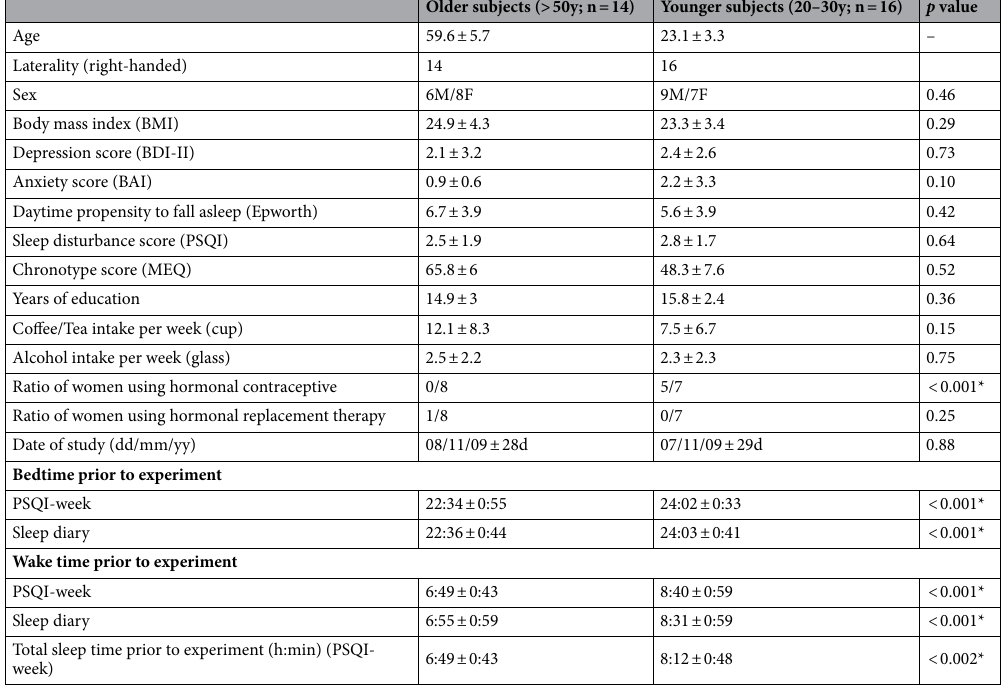
Table 1. Subject characteristics (mean ± SD). BDI-II beck depression inventory-II, BAI beck anxiety inventory, PSQI Pittsburgh sleep quality index, MEQ morningness–eveningness